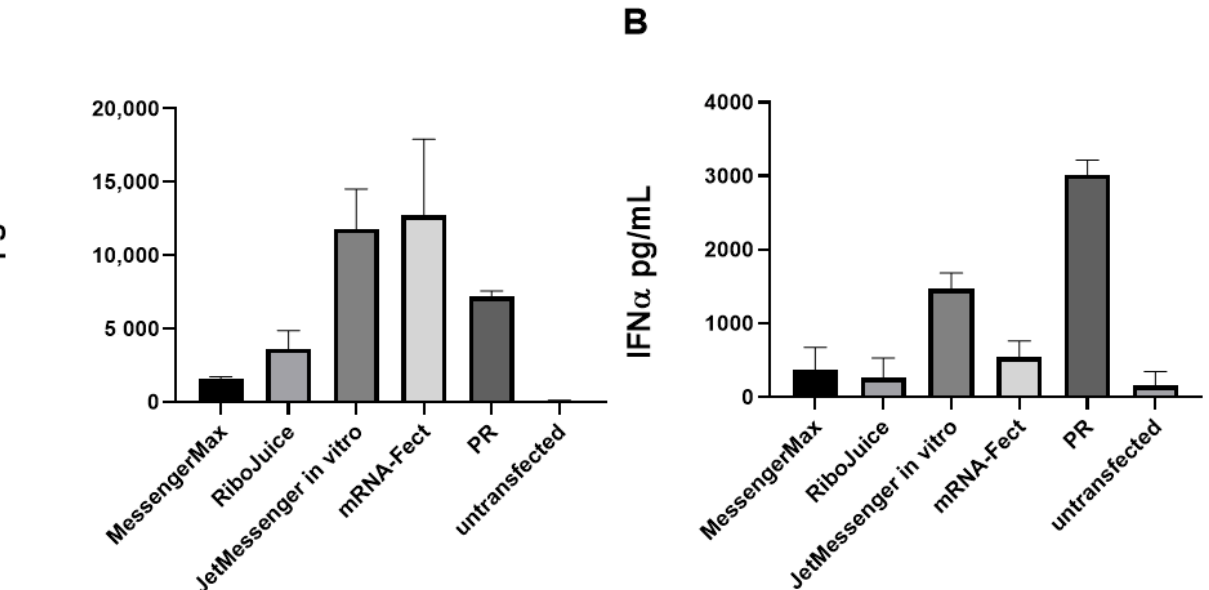
Figure 2. Immune stimulation of mRNA carriers in human PBMCs and murine splenocytes. Cells were seeded at 100,000 cells per well in a 96-well plate and transfected with 200 ng of mRNA per well. Twenty-four hours post transfection supernatants were subjected to ELISA analysis. Selected transfection reagents were tested for their ability to stimulate the production of IFN α in human ( A ) and murine ( B ) immune cells. PR: protamine–RNA nanoparticles. Data represent triplicate mean values; error bars: SD.